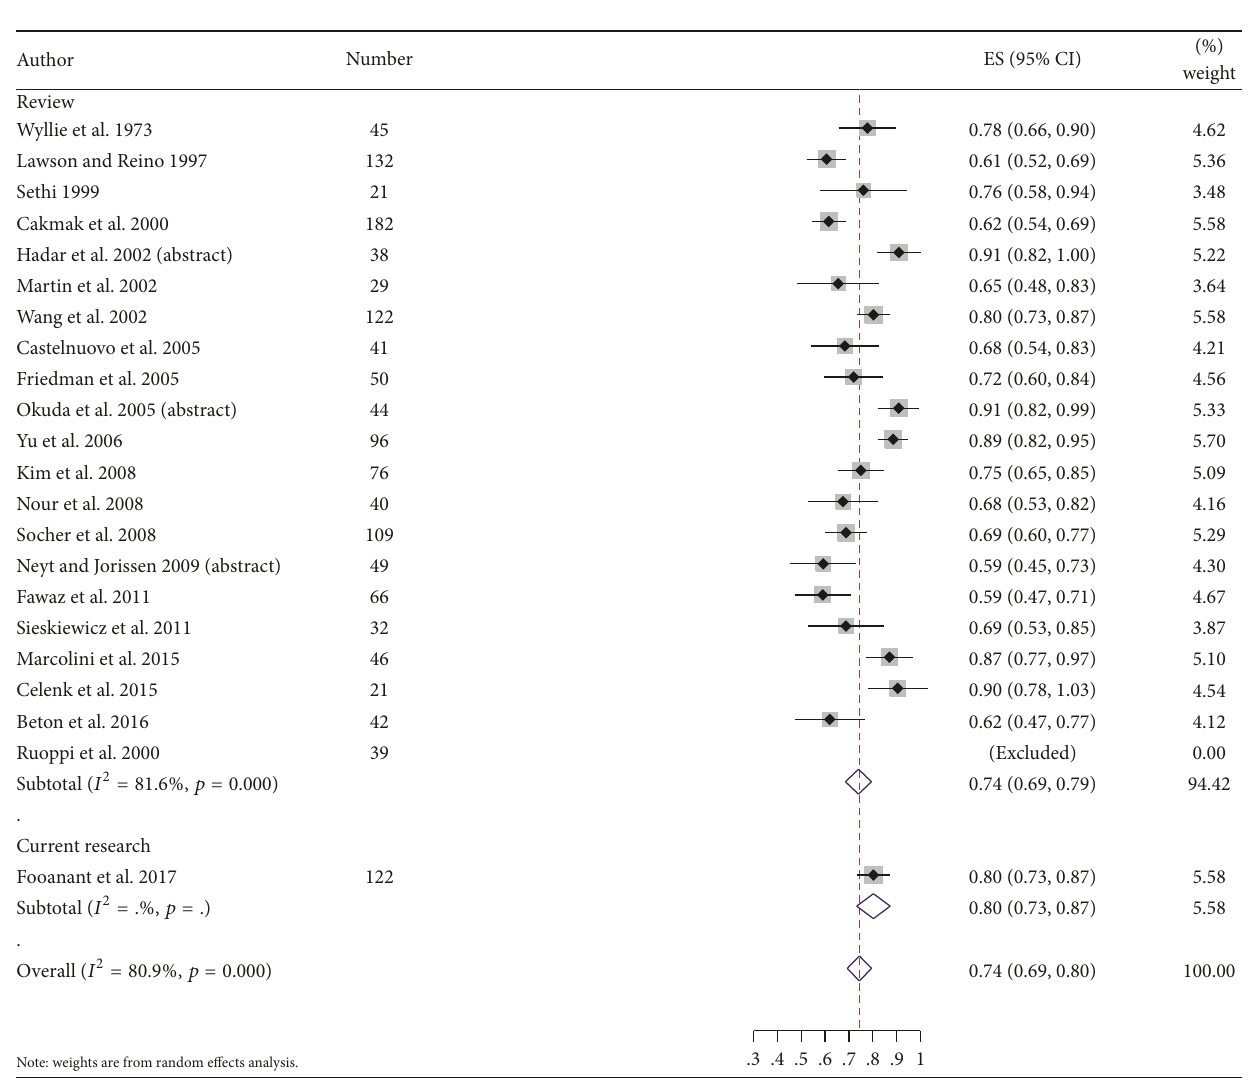
the tumor category with no detailed data; however, in this review, the authors classified them as tumors. Overall, tumors were found in 18.9% [95% CI: 0.145, 0.232] (Table 3) and malignant tumors were found in 7.0% [95% CI: 0.045, 0.095] (Figure 4). The frequency of fibrous dysplasia ranged from 1.5 to 13.1% while that of ossifying fibroma ranged from 1.5 to 2.4%. The miscellaneous group included 6.1% [95%